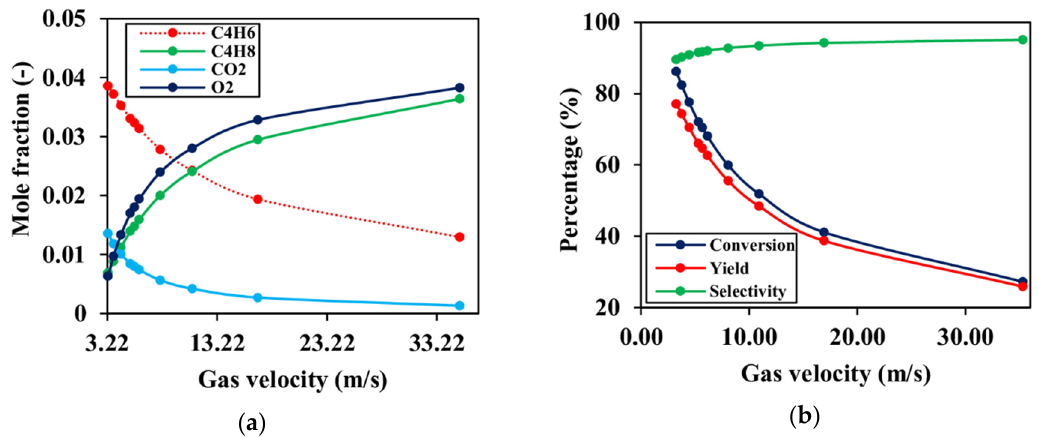
Figure 14. Mole fractions and reactor performance profiles as a function of gas velocity: ( a ) mole fractions; ( b ) conversion, yield, and selectivity.